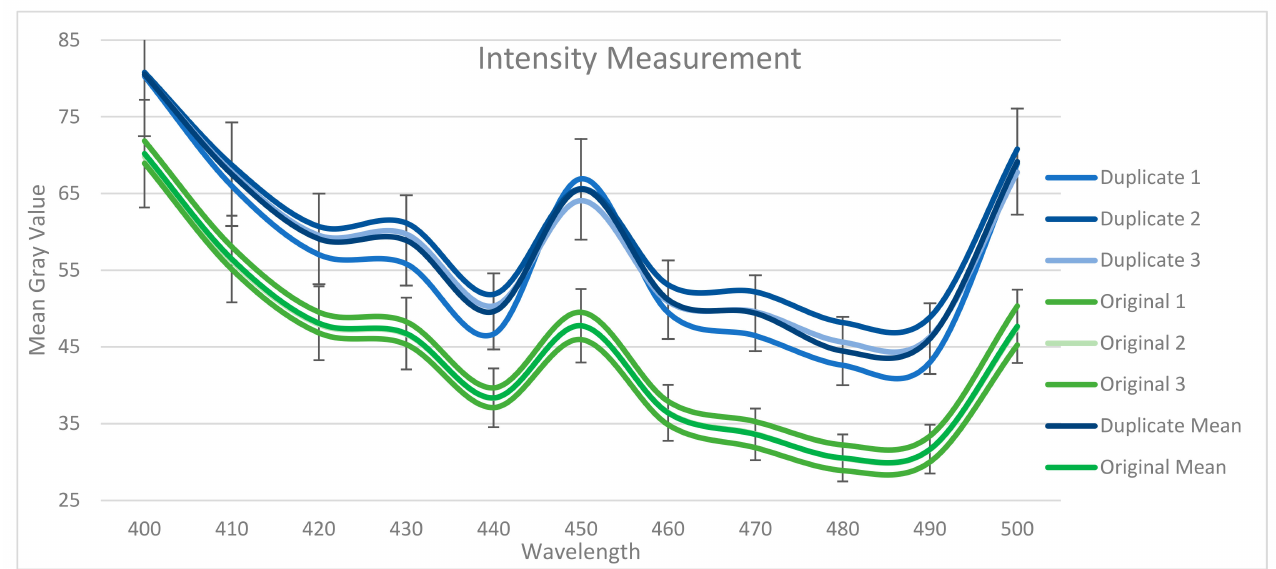
Figure 6. MGVs of the duplicate and original samples in ROI